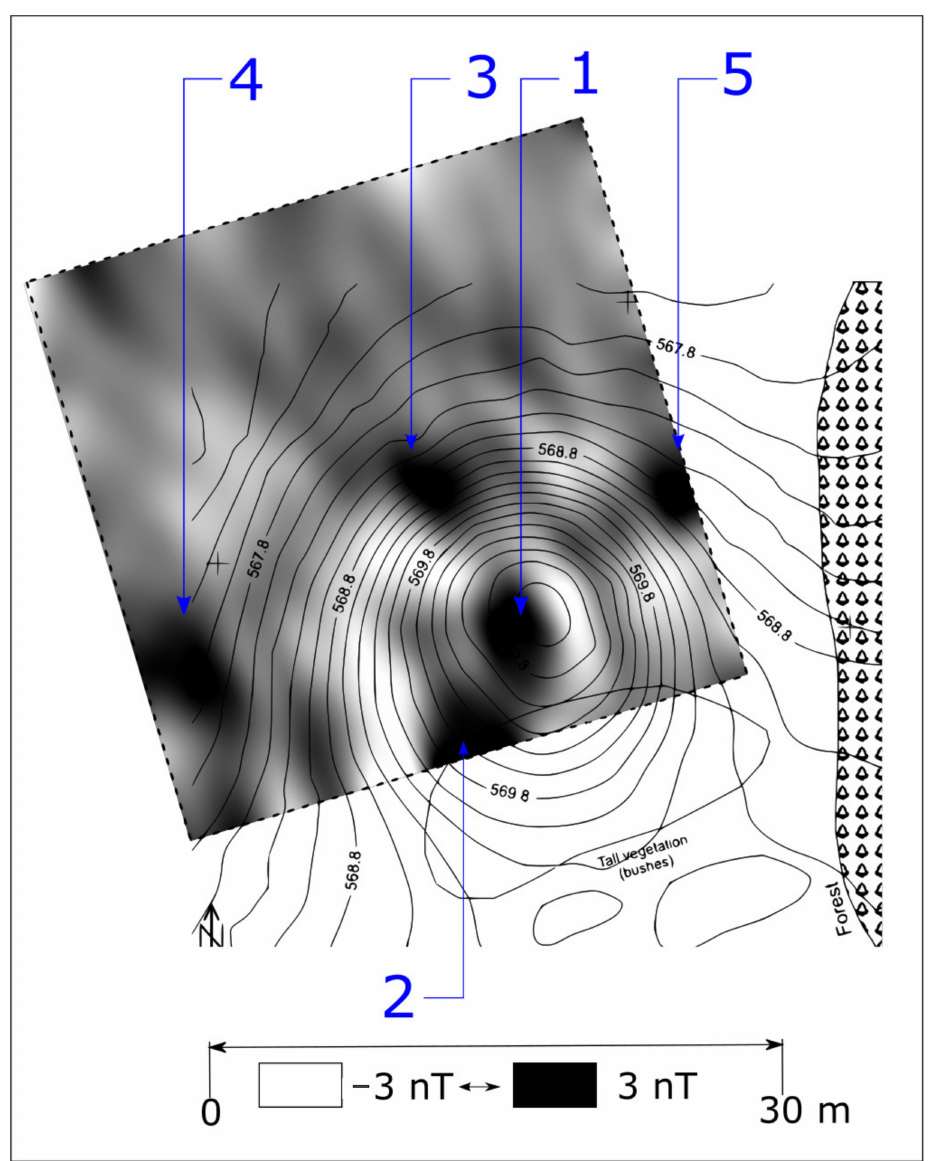
Figure 10. Geomagnetic map (dynamics − 3 to +3 nT) of the mound overlayed by the mound contours extracted from the digital elevation